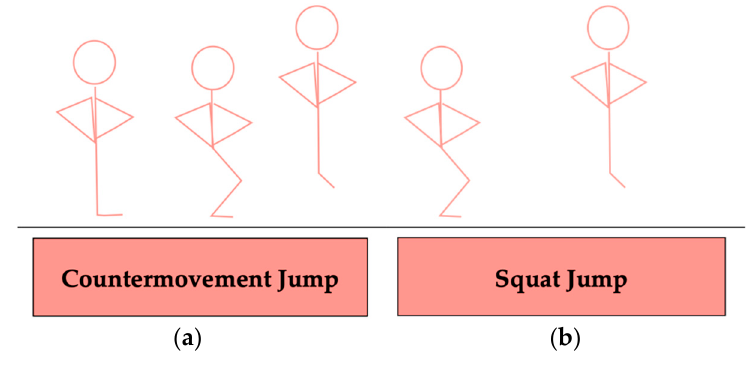
Figure 2. ( a ) Countermovement Jump; ( b ) Squat Jump.